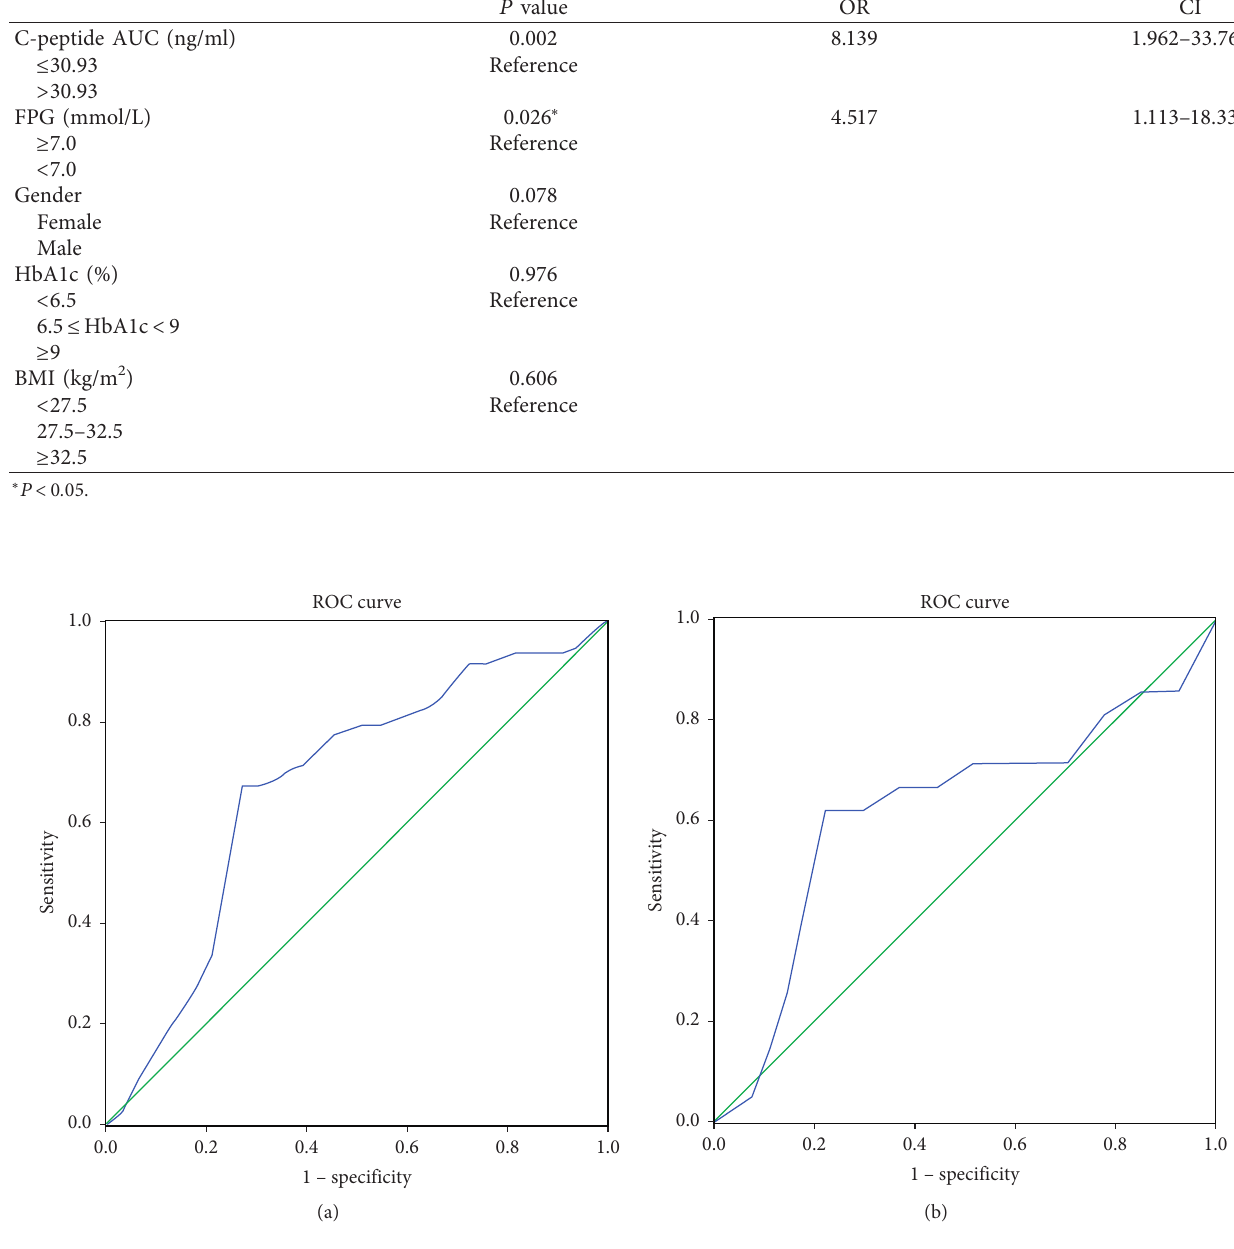
Figure 1: ROC curve of C-peptide AUC in predicting T2D remission. (a) The area under the ROC curve for prediction of short-term T2D remission using C-peptide AUC was 0.674 (specificity: 67.3%; sensitivity: 75.8%). (b) The area under the ROC curve for prediction of long- term T2D remission using C-peptide AUC was 0.623 (specificity: 61.9%; sensitivity: